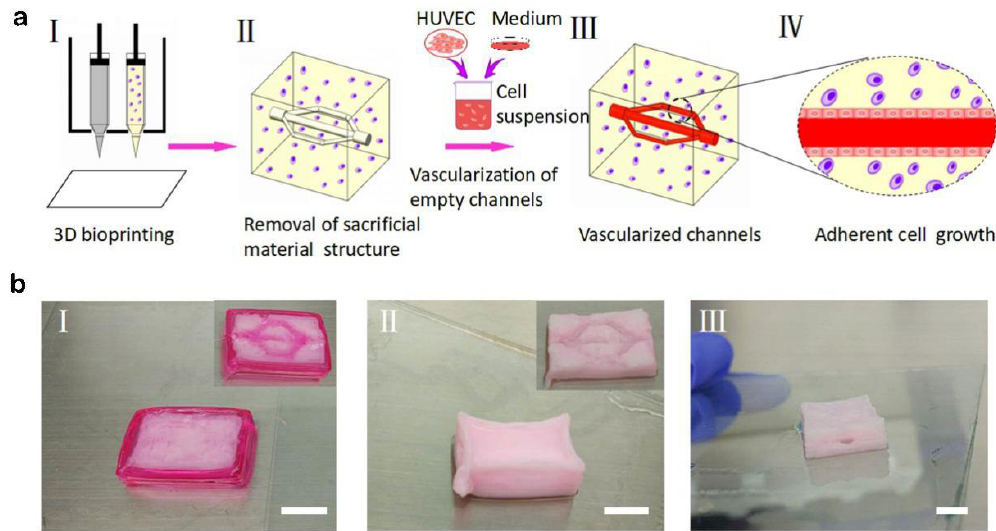
Figure 6. A multibranch channel structure printed by this method. ( a ) Schematic illustration showing the procedure of biofabricating thick tissues with multibranch channels. (I) In the 3D bioprinting process, Pluronic F127 as the fugitive ink and cell-laden dECM as the matrix were bioprinted. (II) After the tissue was immersed in a constant-temperature bath for 1 h, Pluronic F127 was liquefied and removed. Next, perfusable hollow channels were formed, and (III) endothelialized afterwards. (IV) The suspension of HUVECs was perfused to the inside of the hollow channel to form the intact endothelial layer. ( b ) Actual pictures of a multilevel channel structure. (Scale bars: 1 cm).